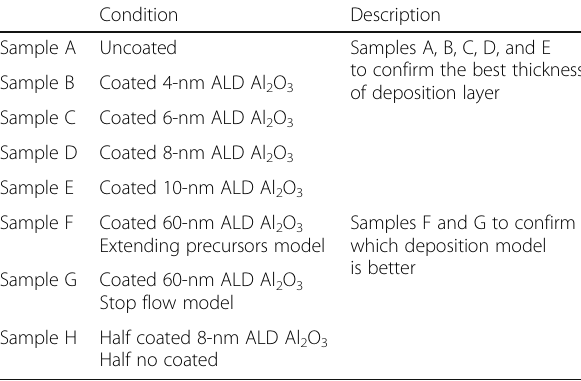
Table 1 Details of experimental samples for ALD Condition